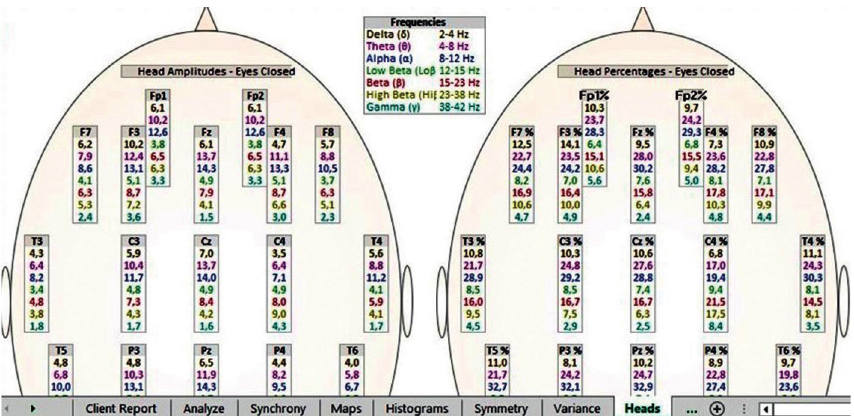
Figure 1. Percentage expected quantity of beta waves (15-23 Hz) and Beta-Alta (23-38 Hz) at the T3 and T4 points of the 10-20 electroencephalography system in a summary statistical distribution (TQ-7 analyze page), expressed in black color, representing the control group.